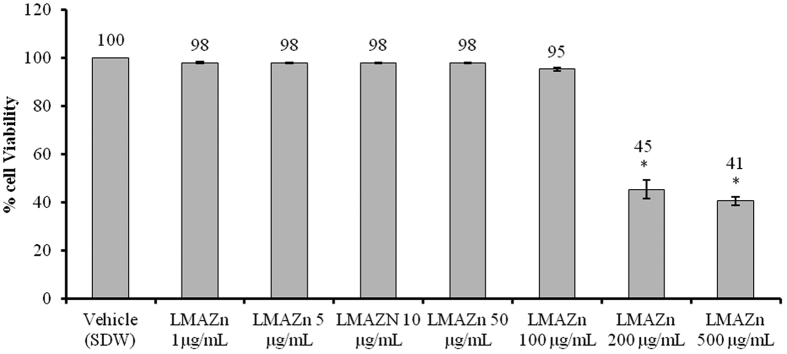
Cytotoxicity data for Zn(L)SCN in the normal human gastric cell line GES-1.Data are reported as Mean ± SEM (n = 3). Asterisks (*) indicate significant (P < 0.05) differences relative to the vehicle (RPMI-1640). SDW denotes sterile distilled water and Zn(L)SCN denotes 2-morpholino-N-[1-(2-pyridyl)-ethylidene] ethanamine-k3N,N′,N″ bis (thiocyanato-kN) zin(II).